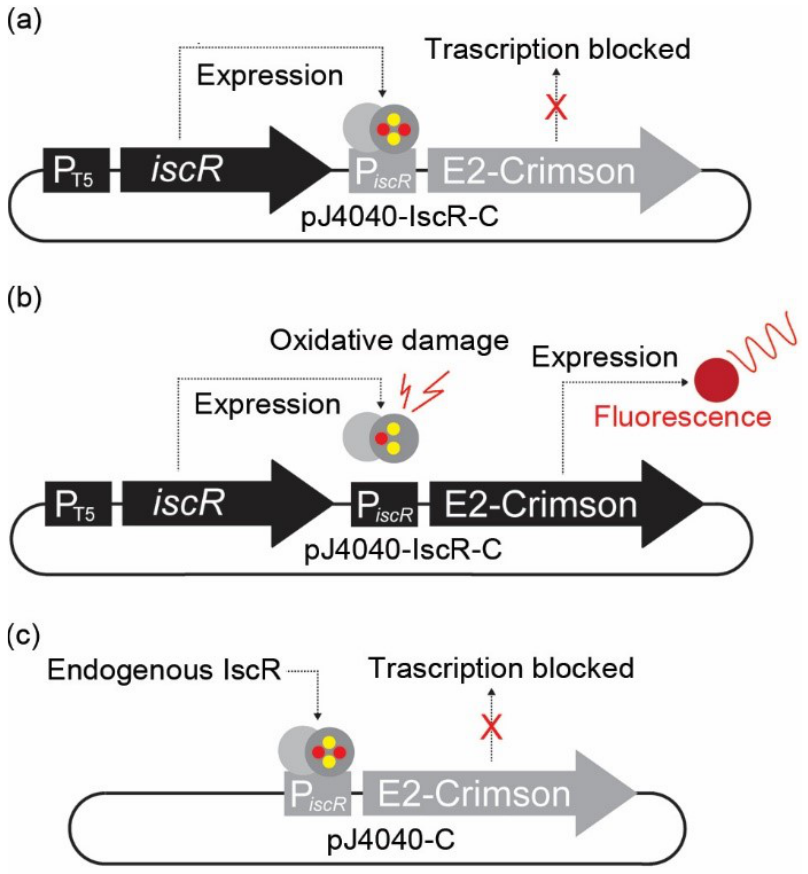
Figure 1. Representation of the plasmid-based in vivo fluorescent reporter system for Fe-S cluster damage designed in this study. ( a ) In pJ404-IscR-C, the E2-Crimson gene expressing the fluorescent reporter protein has been placed under the regulation of iscR promoter (P iscR ), which is effectively suppressed in the presence of intact transcriptional repressor IscR. Consequently, no fluorescent signal is detected under normal conditions when IscR is expressed under the regulation of IPTG-inducible T5 promoter. ( b ) Under oxidative stress, the IscR [2Fe-2S] cluster is damaged, and the protein can no longer bind the promoter repressor region. This results in the expression of E2-Crimson protein and allows the detection of a red fluorescence signal. ( c ) In the modified construct pJ404-C, the IscR protein is not overexpressed from the reporter plasmid, and the repression of E2-Crimson relies on the endogenous IscR present in the E. coli